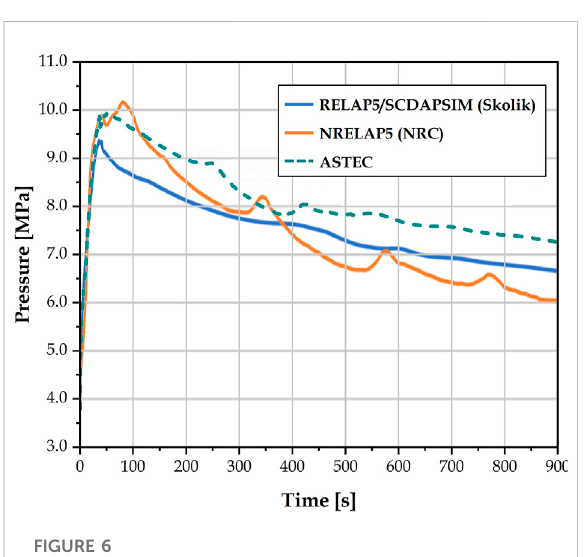
FIGURE 6 Turbine trip transient: Secondary pressure.